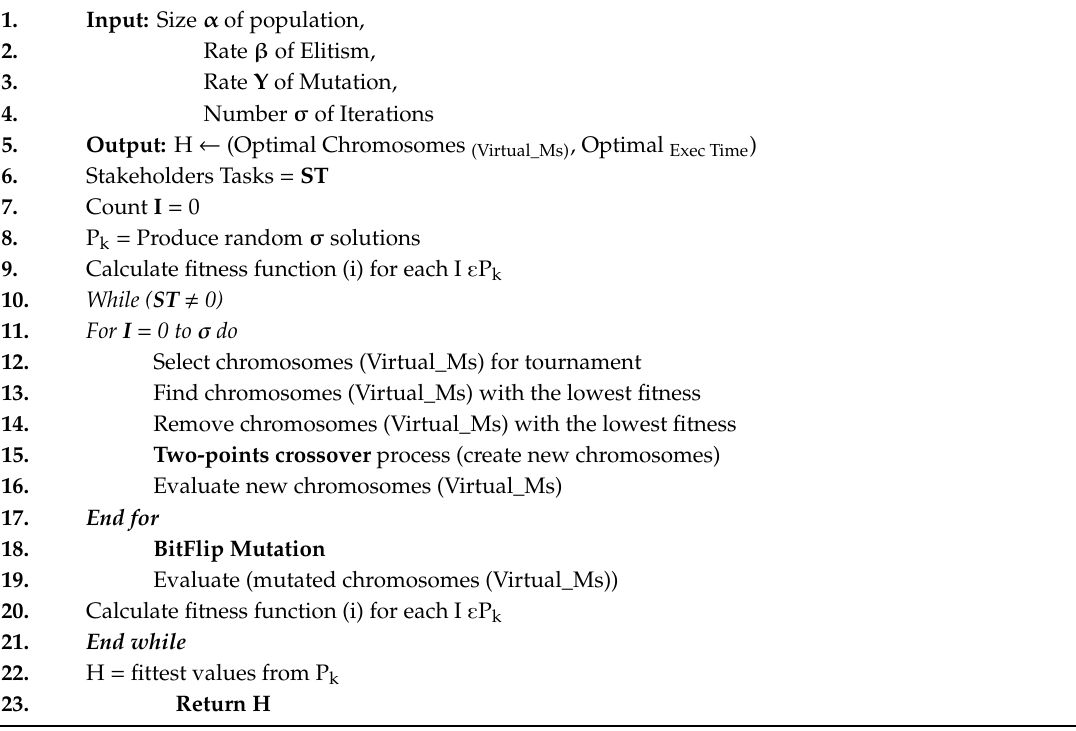
Algorithm 1. Genetic Algorithm (GA) Steps for Selecting Virtual_Ms on Cloud